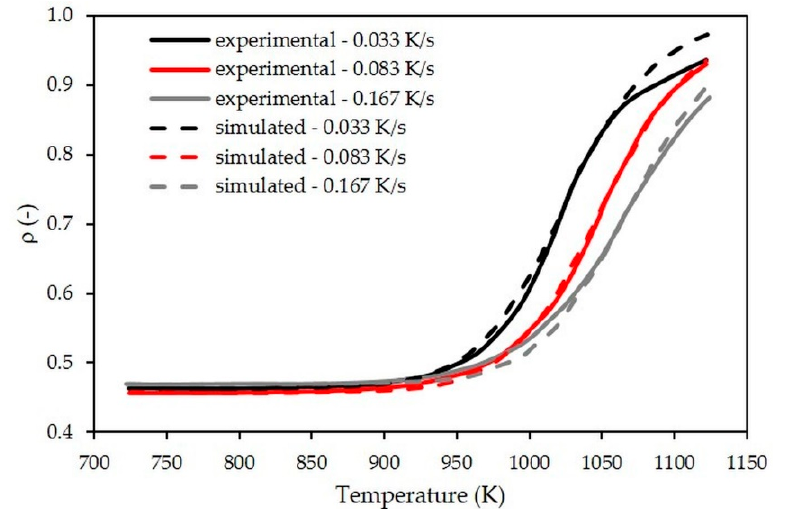
Figure 4. Comparison between simulated and measured densification curves during free sintering for different heating rates applied up to 1123 K.